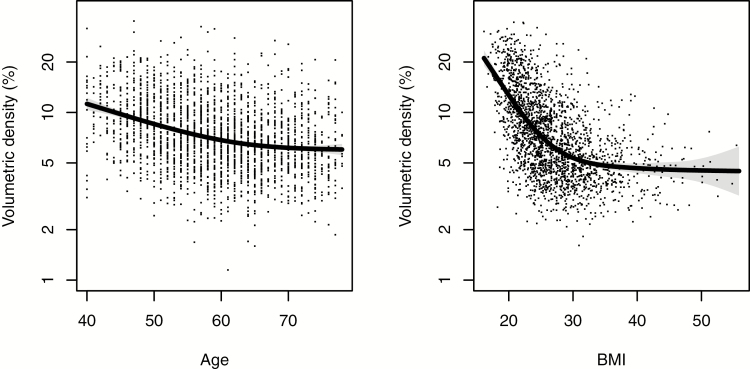
Association between volumetric percent density, age, and BMI in control participants. Points show the actual density for each woman, and the line corresponds to the smoothed expected percentage density for a woman of the given age or BMI; standard errors are shaded around the line.